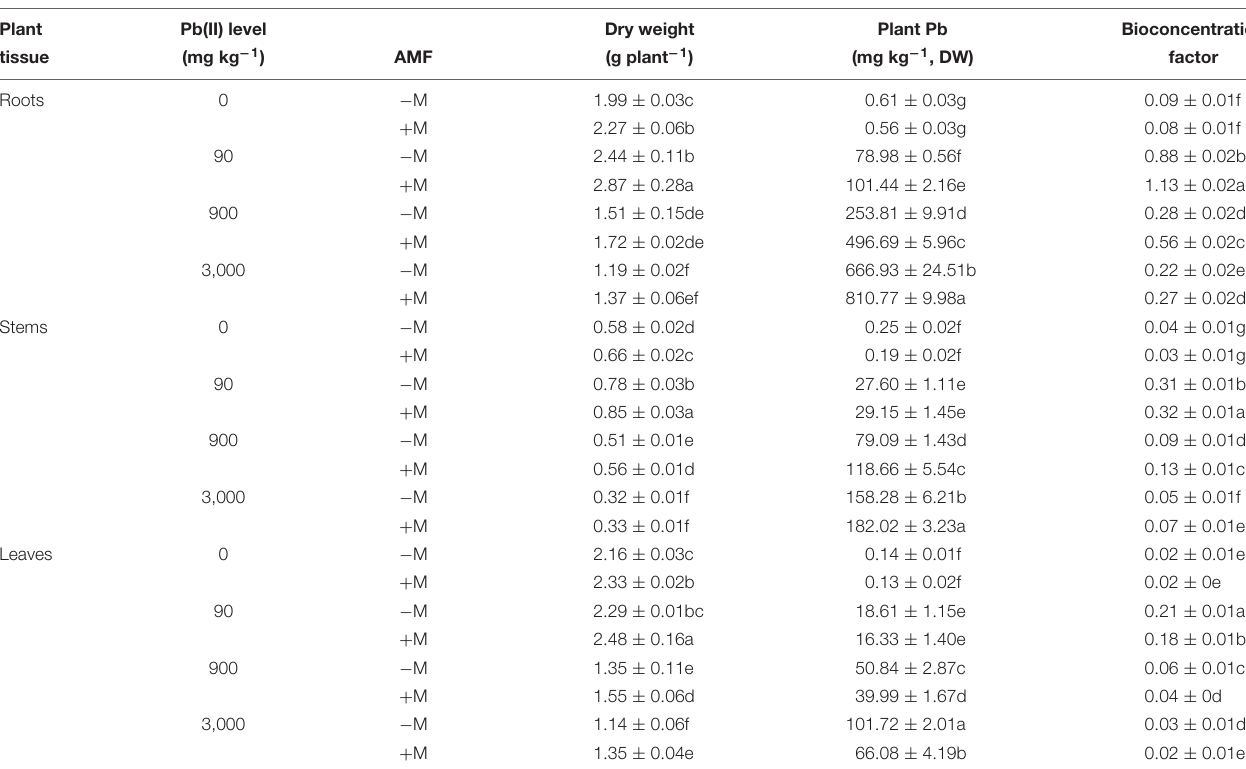
TABLE 2 | Plant dry weight, Pb concentrations, and bioconcentration factor of Pb in various tissues of Robinia pseudoacacia seedlings in response to different Pb levels (0, 90, 900, and 3,000 mg Pb kg − 1 soil) for 4 months.